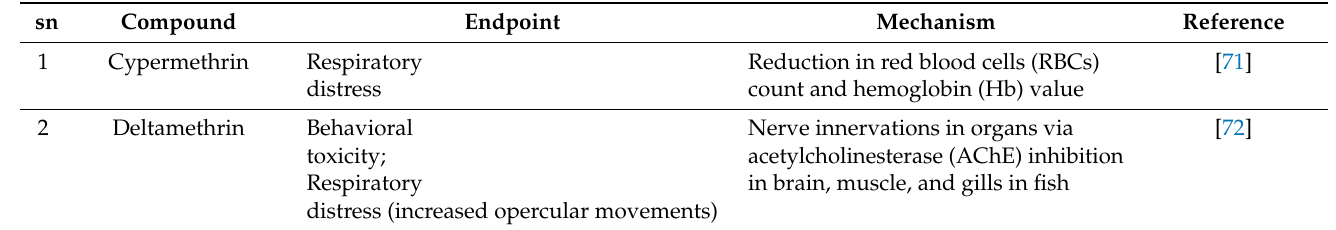
Figure 7. AOP for ( a ) respiratory impairment and ( b ) behavioral toxicity by deltamethrin in O. mossambicus . The boxes represent toxic responses documented in aquatic species, including O. mossambicus exposed to deltamethrin. Arrows denote postulated Key Event Relationships (KER). Table 2. Documented toxicity mechanisms of deltamethrin on fish and other